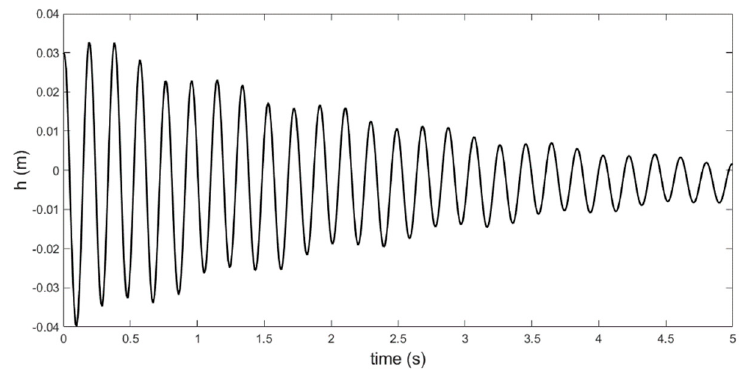
Figure 16. Time response of “h” in lower speed of flutter (20 m/s).